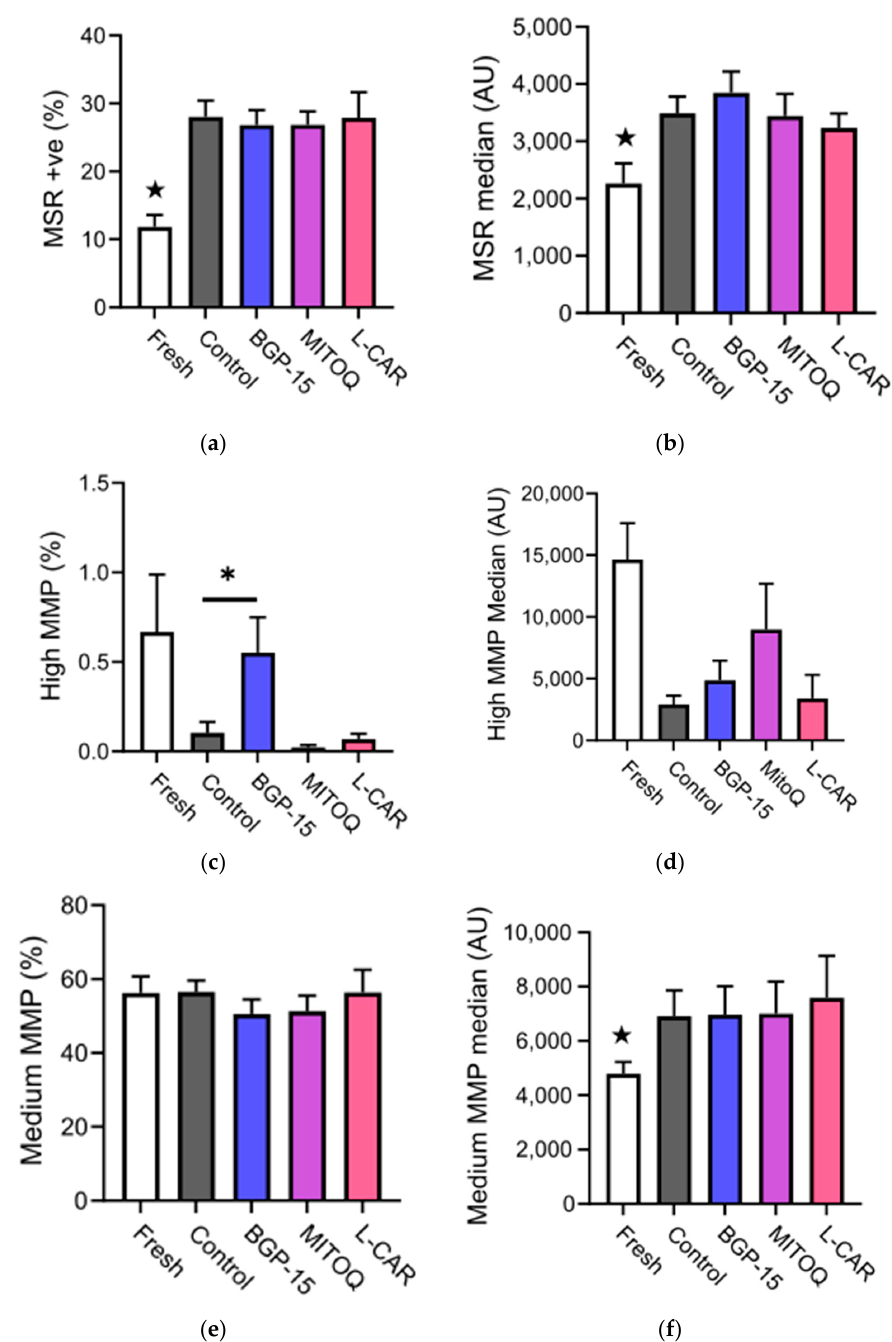
Figure 2. Effect of mitochondrial activators on sperm superoxide levels and mitochondrial mem- brane potential. ( a ) Percentage of sperm with high mitochondrial ROS in all pre- (fresh) and